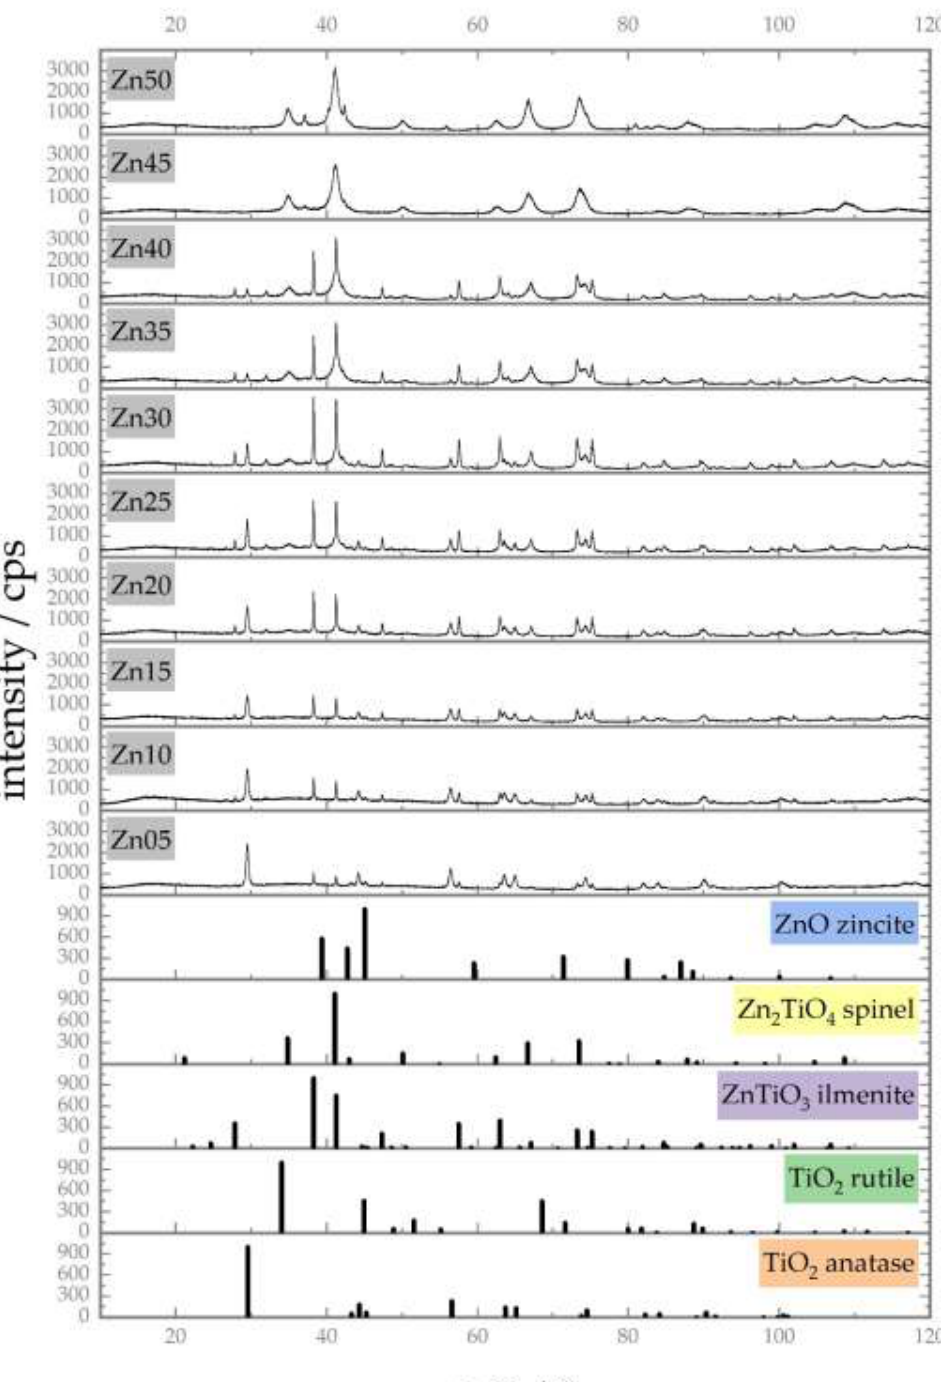
Figure 4. Powder X-Ray Di ff raction (PXRD) pattern of catalyst materials Zn05 to Zn50, as well as reference data of TiO 2 (anatase ICDD 73-1764 and rutile ICDD 73-1765), ZnTiO 3 ilmenite (ICDD 85-0547), Zn 2 TiO 4 spinel (ICDD 73-0578) and ZnO (ICDD 80-0075), acquired on a Bruker D8 di ff ractometer with Co fine focus tube ( λ K α = 1.79021 Å, Θ - Θ geometry, VDS, Lynxeye detector). The number in the catalyst’s name (ZnXX) indicates the amount of zinc in comparison to the amount of titanium used for synthesis in mol-percent.